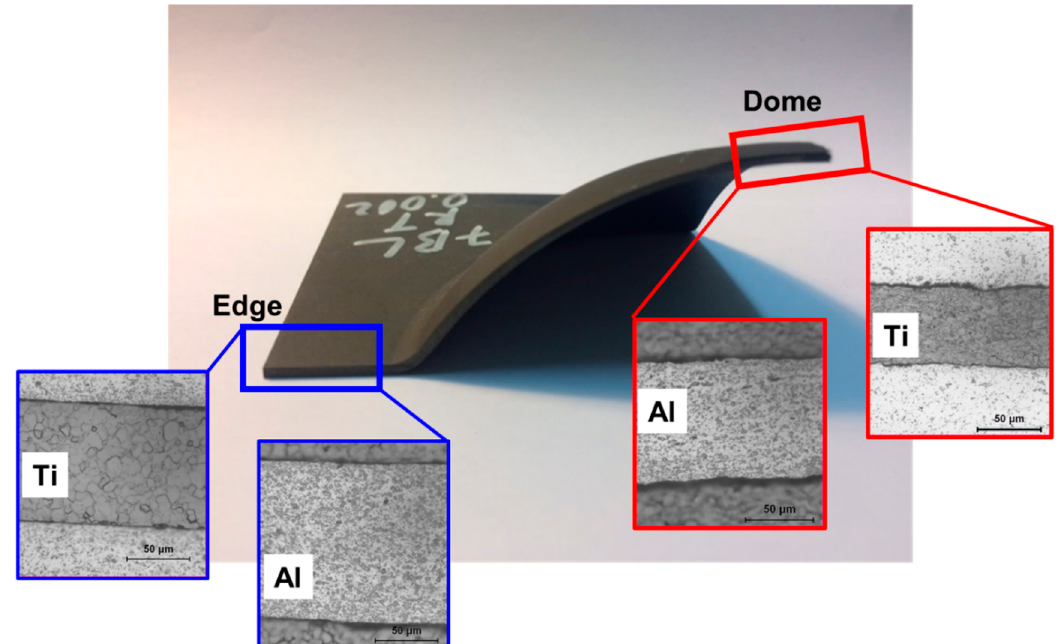
Figure 11. The images showing the Al and Ti layers at the edge and dome regions of the bulged sample.